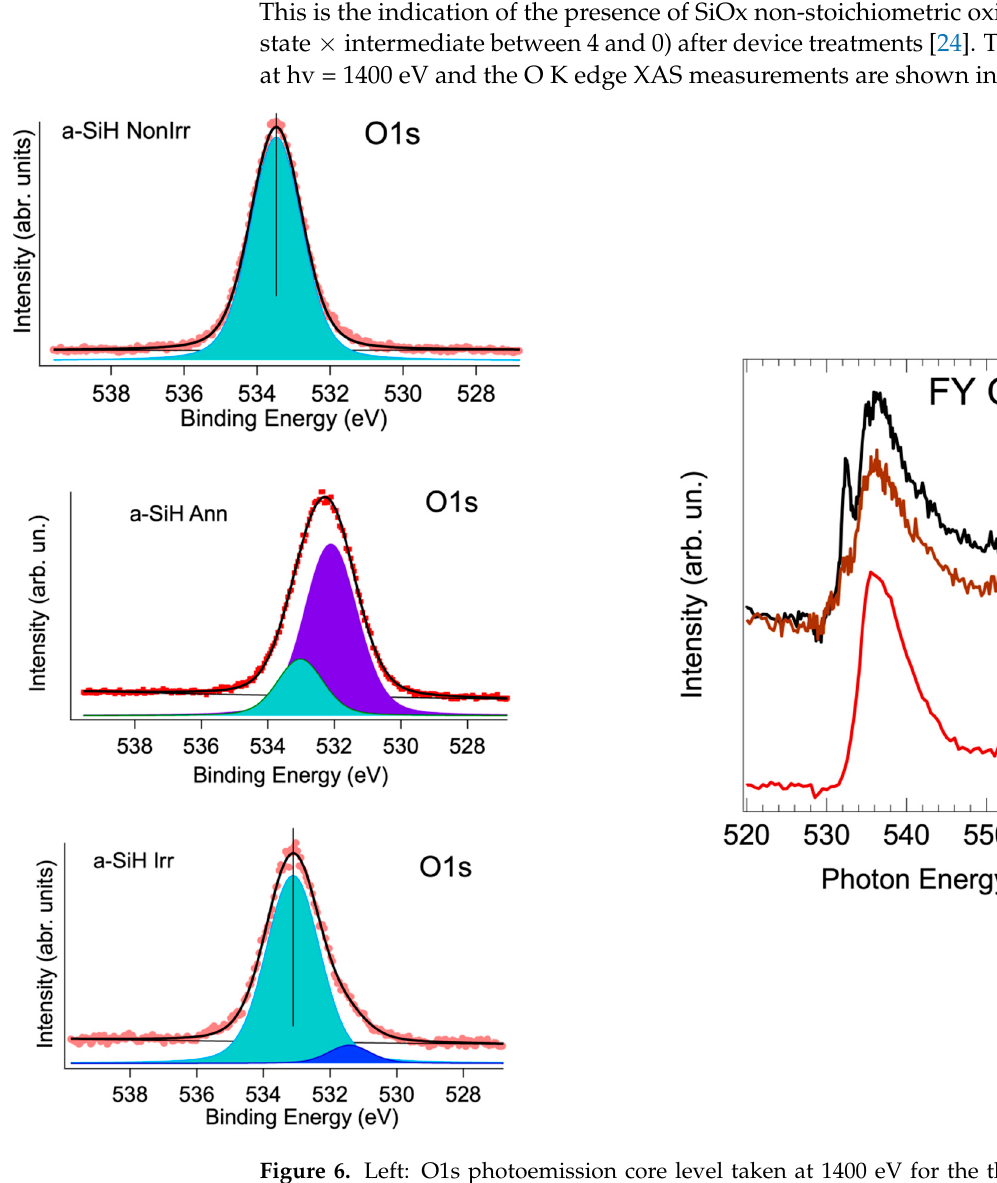
Figure 6. Left: O1s photoemission core level taken at 1400 eV for the three samples. The Non-irradiated sample is a single peak at 533.4 eV, as expected in SiO 2 coating. Left: O K edge XAS spectra for the three samples.